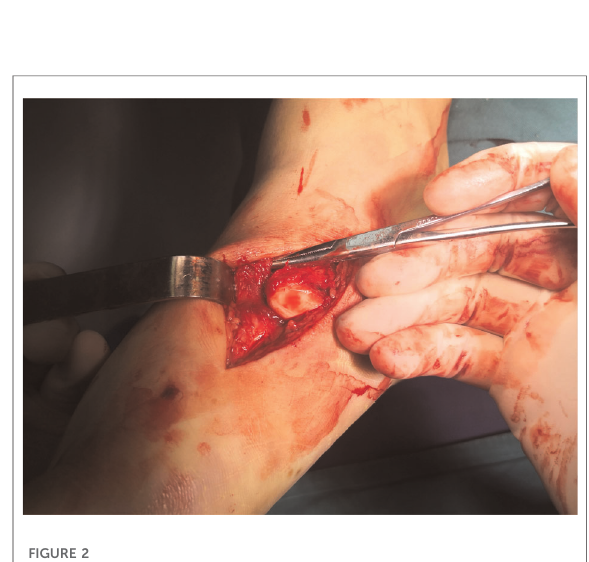
FIGURE 2 Intraoperative exploration showing the joint capsule and extensor hallucis longus tendon embedded in the fi rst metatarsophalangeal and intercuneiform joints.